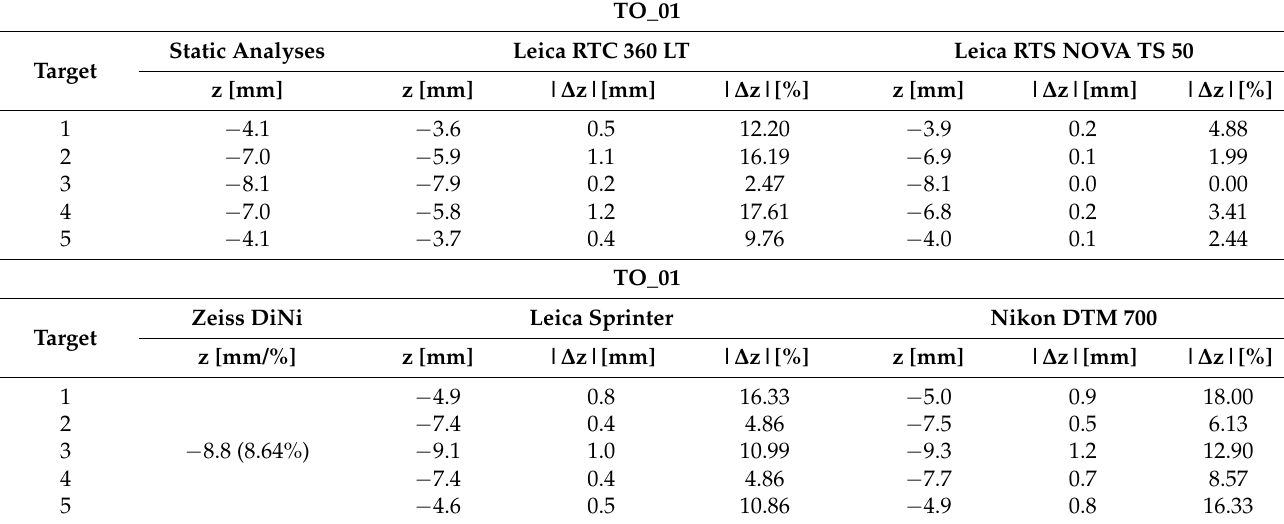
Table 4. Differences and comparisons of measurements with static analyses of the beam